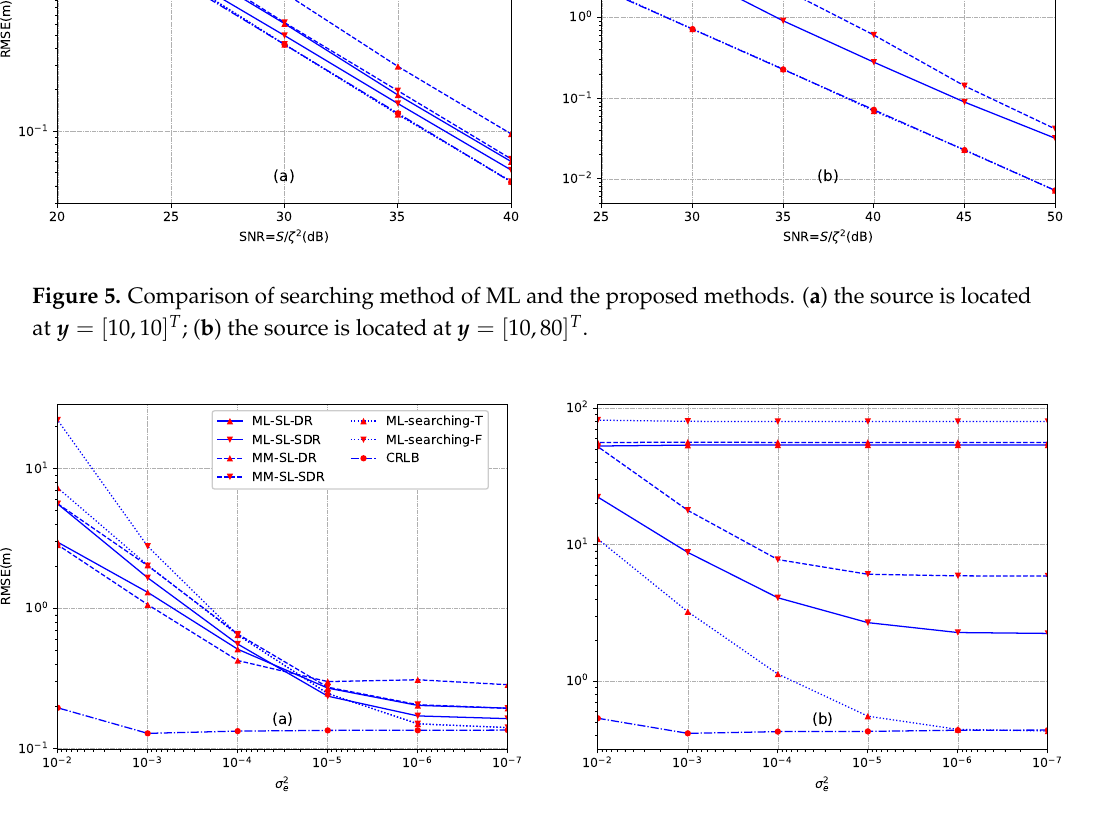
Figure 6. Comparison of searching method of ML and the proposed methods against estimated error of the energy decay factor. ( a ) the source is located at y = [ 10,10 ] T ; ( b ) the source is located at y = [ 10,80 ] T